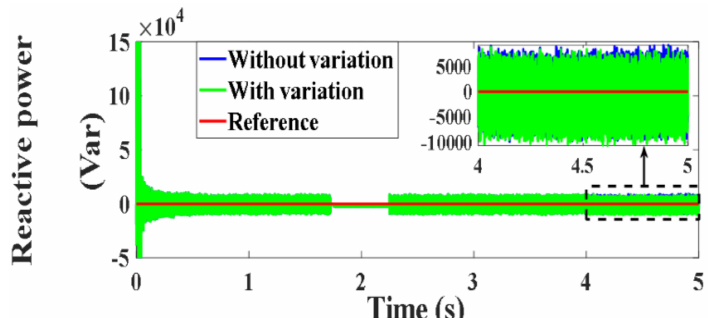
Figure 128. Reactive power under PVC (var).